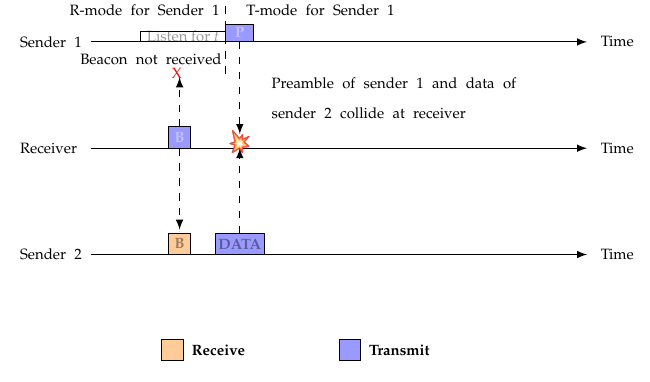
Figure 3. Preamble and data collision.